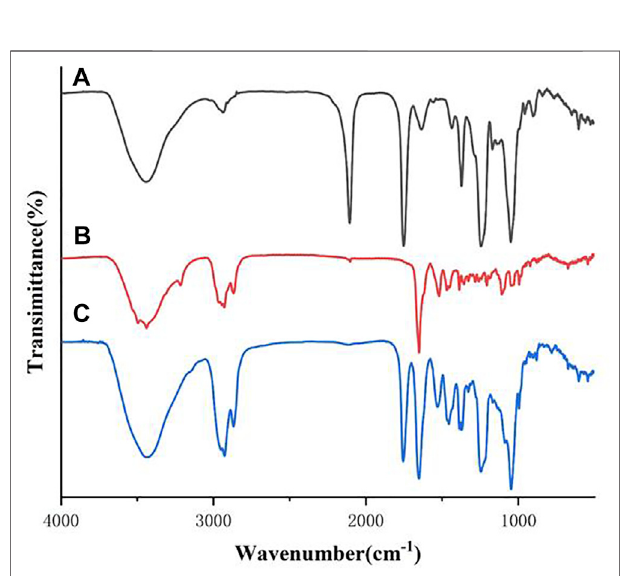
FIGURE2| FTIRspectraofcompounds 11 [ (A) ,black], 17 [ (B) ,red],and their conjugate 21 [ (C) , blue]. Spectra were acquired between 500 and 4,000 cm − 1